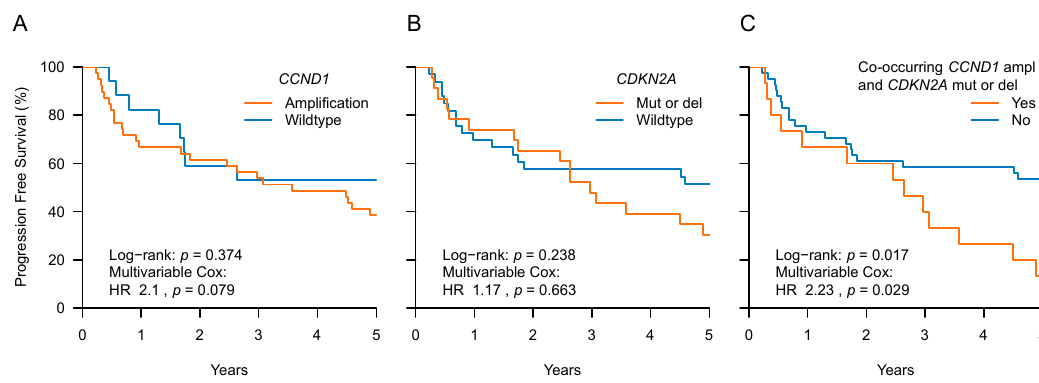
Figure 1. Progression free survival (PFS) according to genetic alterations in CCND1 and CDKN2A . Kaplan–Meier curves of advanced stage pharyngeal HNSCC patients classified according to tumor CCND1 and CDKN2A status: ( A ) CCND1 amplification versus wildtype. ( B ) CDKN2A mutation or deletion versus wildtype. ( C ) CCND1 amplification co-occurring with CDKN2A mutation or deletion, versus wildtype for one or either of these two genes. In-figure legends of A–B state hazard ratios (HR) and corresponding p -values from multivariable Cox models that were fitted on all ( n = 77) samples and included the tested genetic factor, HPV status, and tumor site. In-figure legend of C states the hazard ratio (HR) and corresponding p -value from a multivariable Cox model that was fitted on these HPV-negative samples only ( n = 56) and included the tested genetic factor and tumor site. Note, all graphs display Kaplan–Meier curves of HPV-negative samples only ( n = 56) with the corresponding log–rank test.